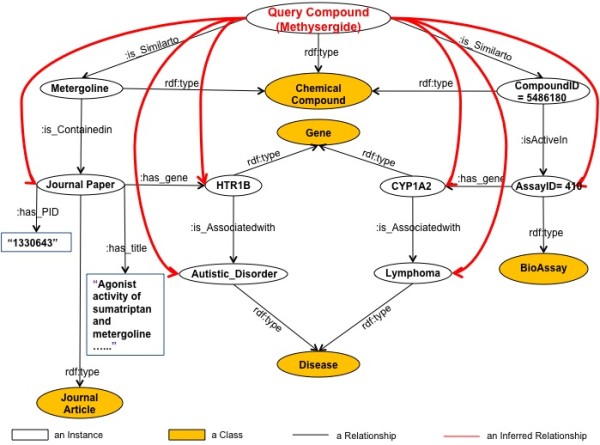
RDF Network for CE.